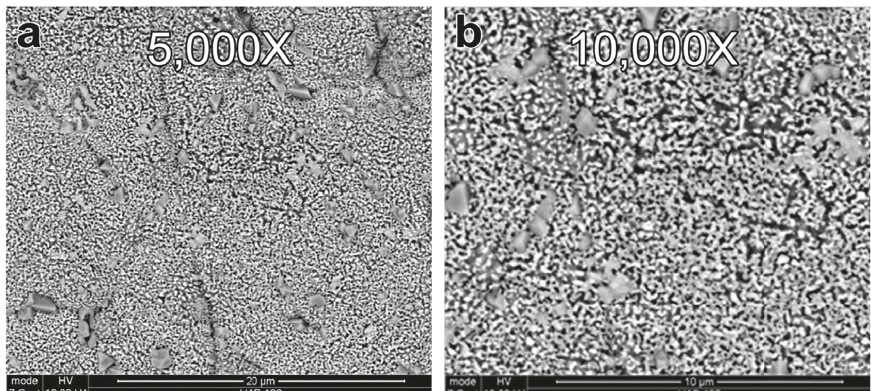
Figure 15: Thermal soak samples: YSZ-B132 (a) at 5,000X and (b) at